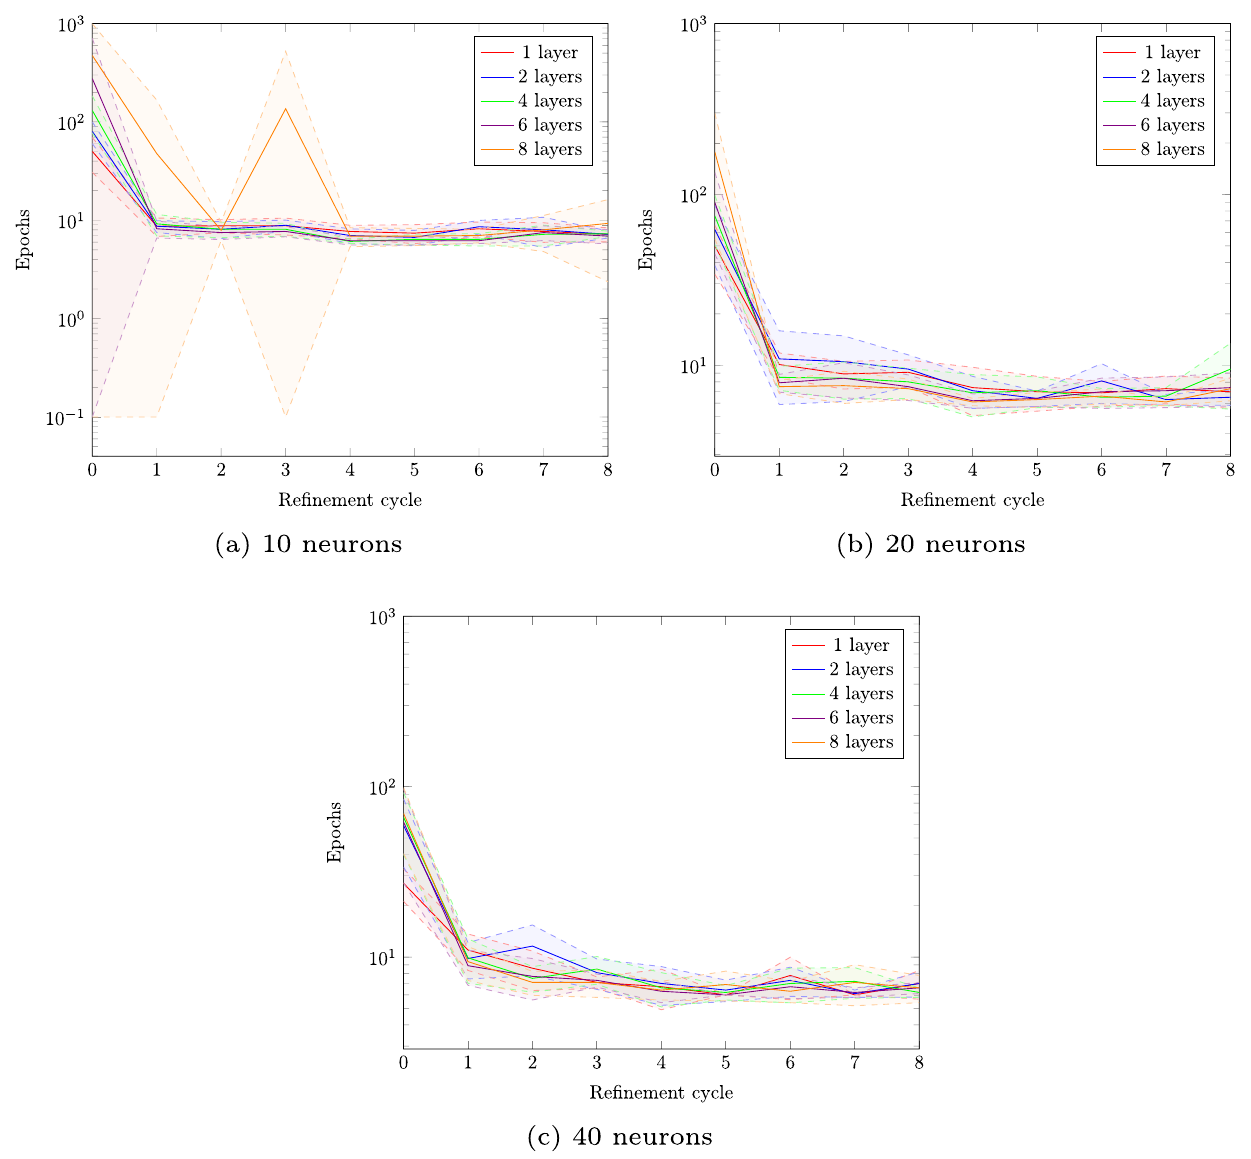
Fig. 5 Section 5.2: Number of epochs per refinement cycle to train neural network for 10 independent runs for the Poisson problem with analytical primal and adjoint